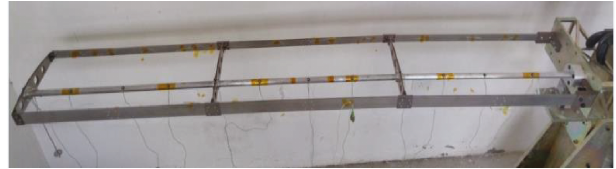
Figure 3: Wing-like